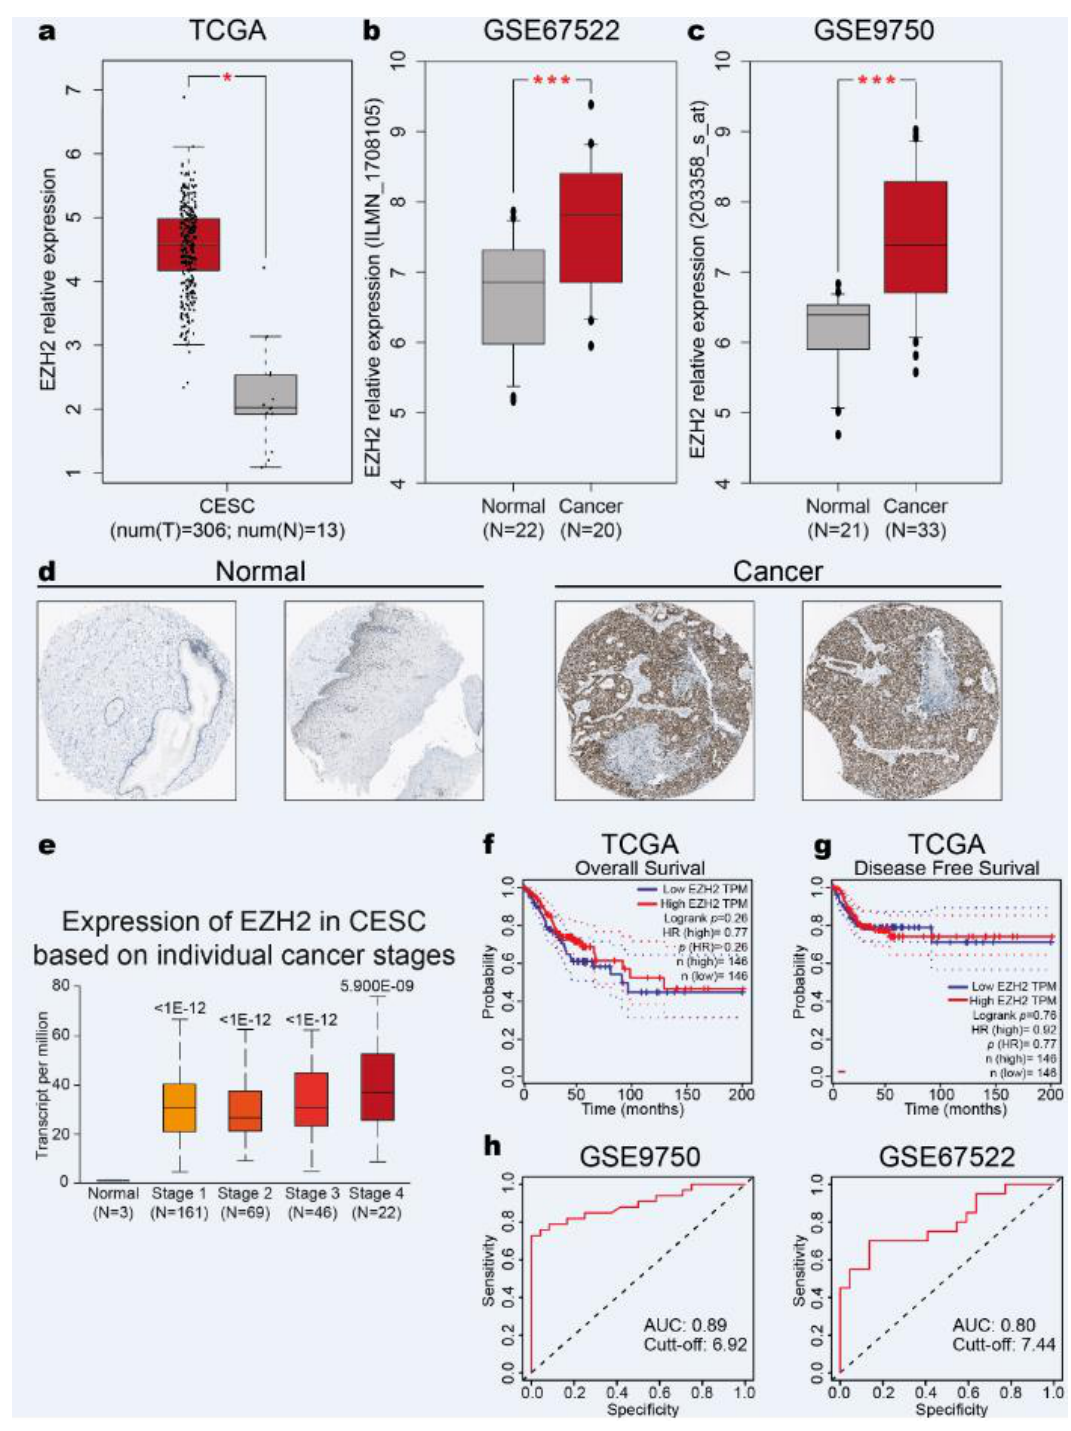
Figure 1: EZH2 expression is increased in cervical cancer. a) EZH2 expression in CC and normal samples from TCGA. One-way ANOVA, p-value ˂0.05. b) EZH2 expression in CC and normal samples from the GSE67522 dataset. Student's t -test, p-value ˂0.05. c) EZH2 expression in CC and normal samples from the GSE9750 dataset. Student's t -test, p-value ˂0.05. d) EZH2 immunohistochemical level in CC and normal samples from The Human Protein Atlas database. Two representative images are depicted. e) EZH2 expression in CC stages and normal samples from TCGA. Student's t -test. p- value is shown. f) Kaplan-Meier OS curves of CC patients with high and low EZH2 expression. Log- Rank test, p-value = 0.26. g) Kaplan-Meier RFS curves of CC patients with high and low EZH2 expres- sion. Log-Rank test, p-value = 0.76. h) ROC curves of EZH2 expression from GSE9750 and GSE67522 datasets.